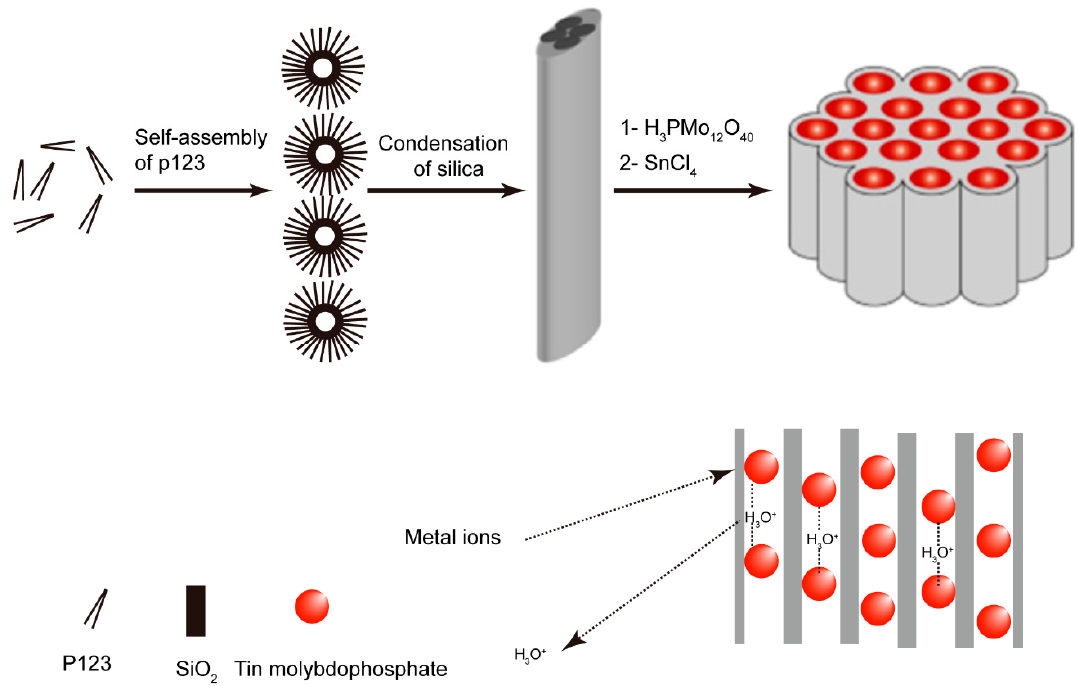
Figure 3. Schematic diagram of the proposed synthesis procedure for immobilization of TMP onto mesoporous silica SBA-15, and the ion-exchange process [32]. mesoporous silica SBA-15, and the ion-exchange process